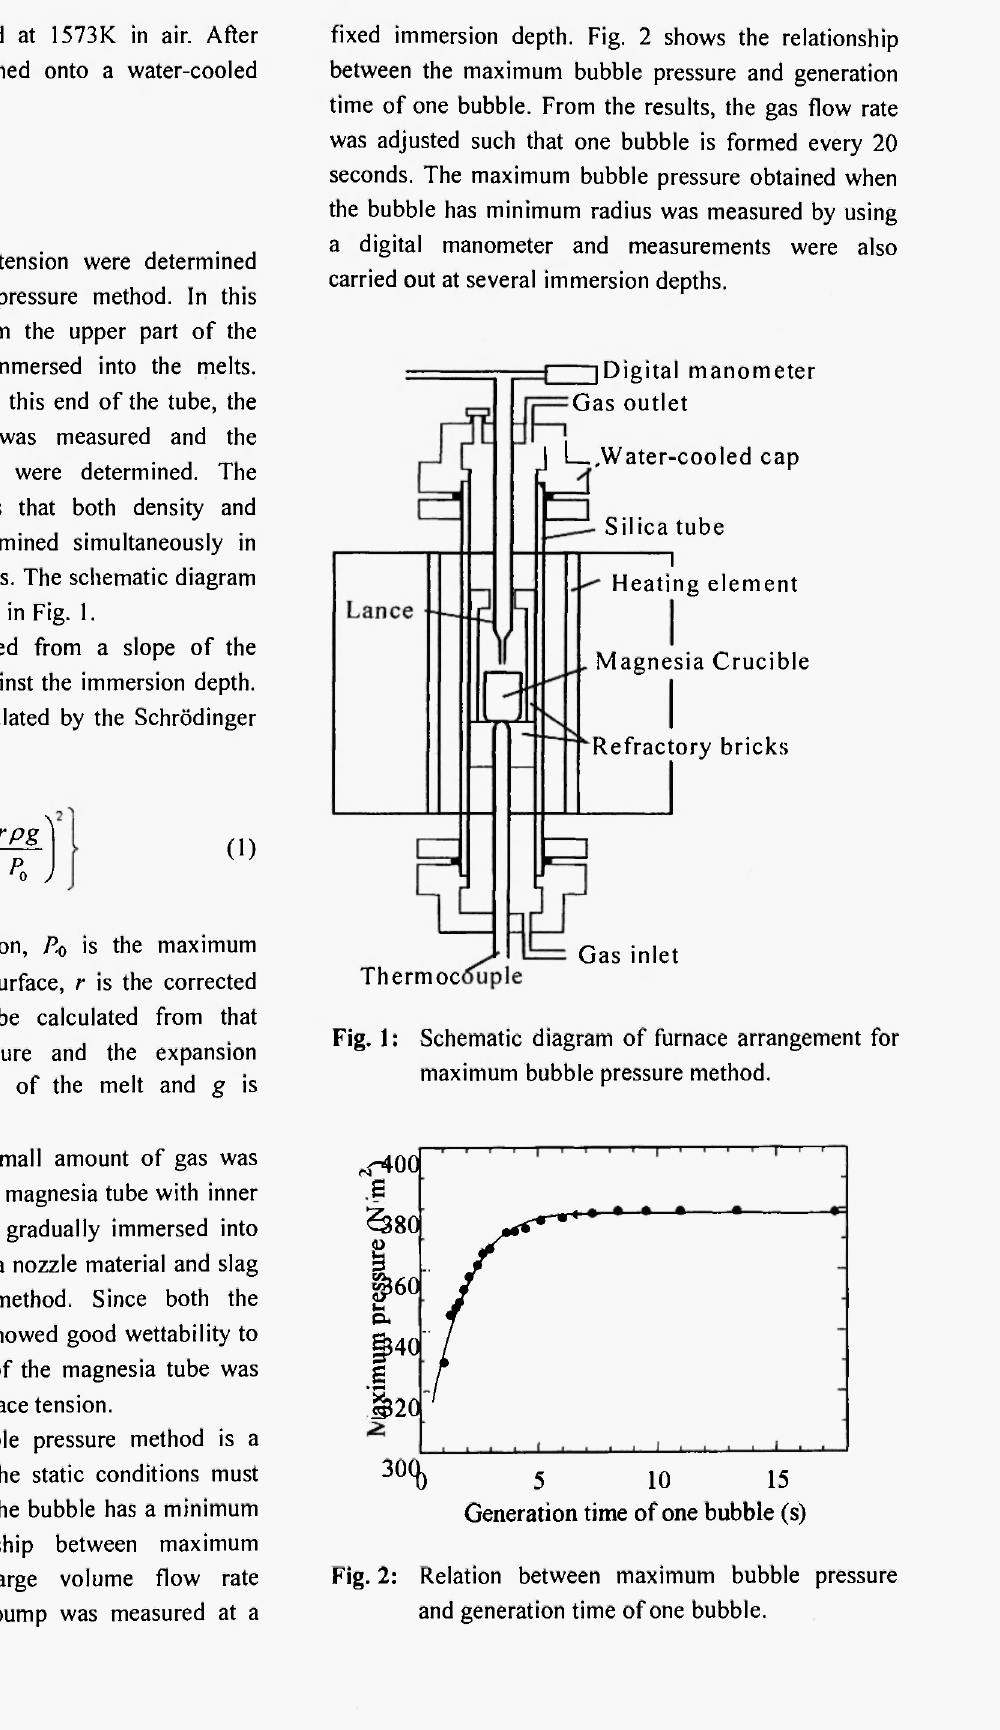
Fig. 2: Relation between maximum bubble pressure and generation time of one